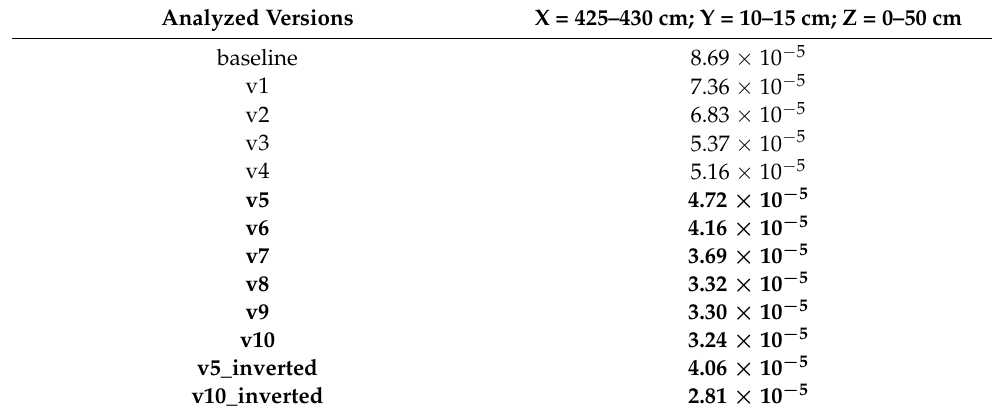
Table 2. Nuclear heating (W/cm 3 ) at first cm of TFC.